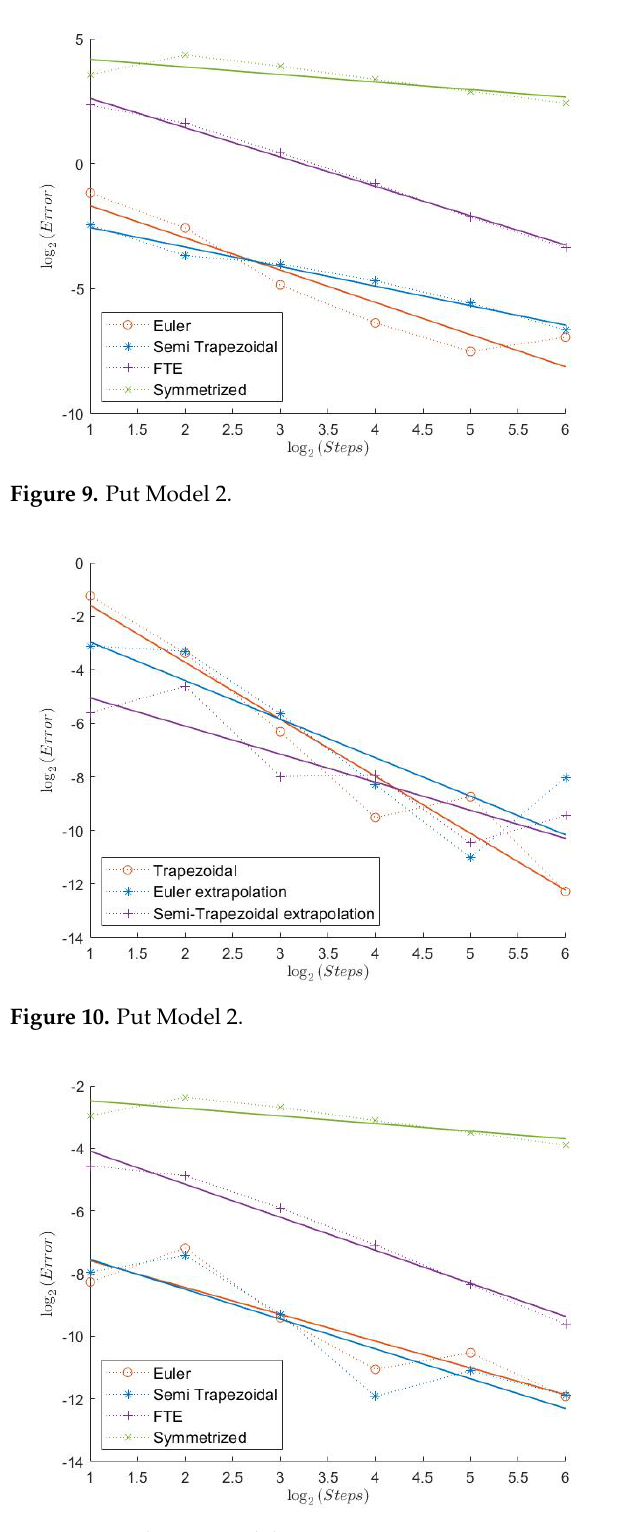
Figure 11. Indicator Model